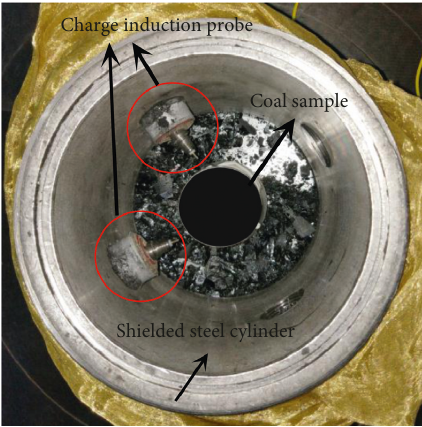
Figure 5: Charge induction probe